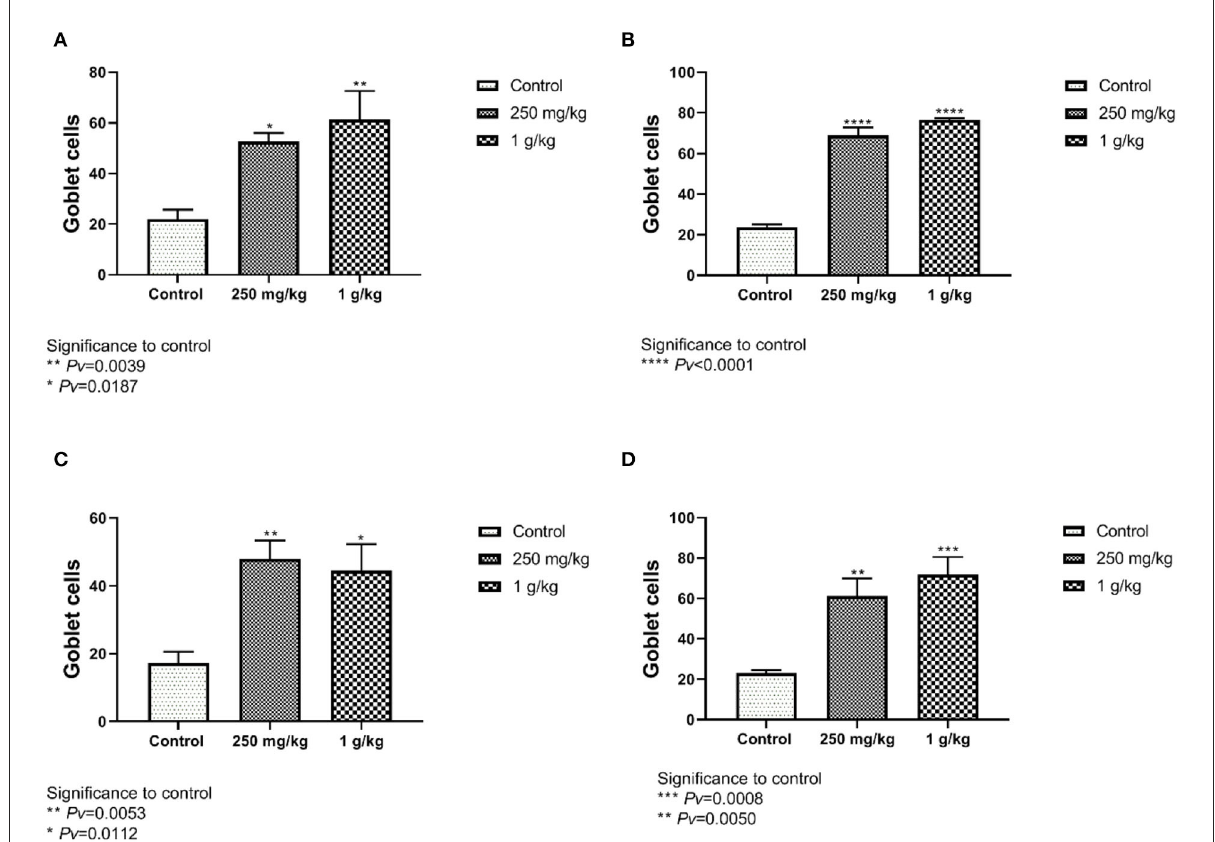
FIGURE8 The number of goblet cells counted from the jejunum and ileum sections. Beta-glucans treatment groups compared to the control. (A) Females ileum, (B) male ileum, (C) female jejunum, (D) male jejunum (n = 5 per group). Pv is compared to